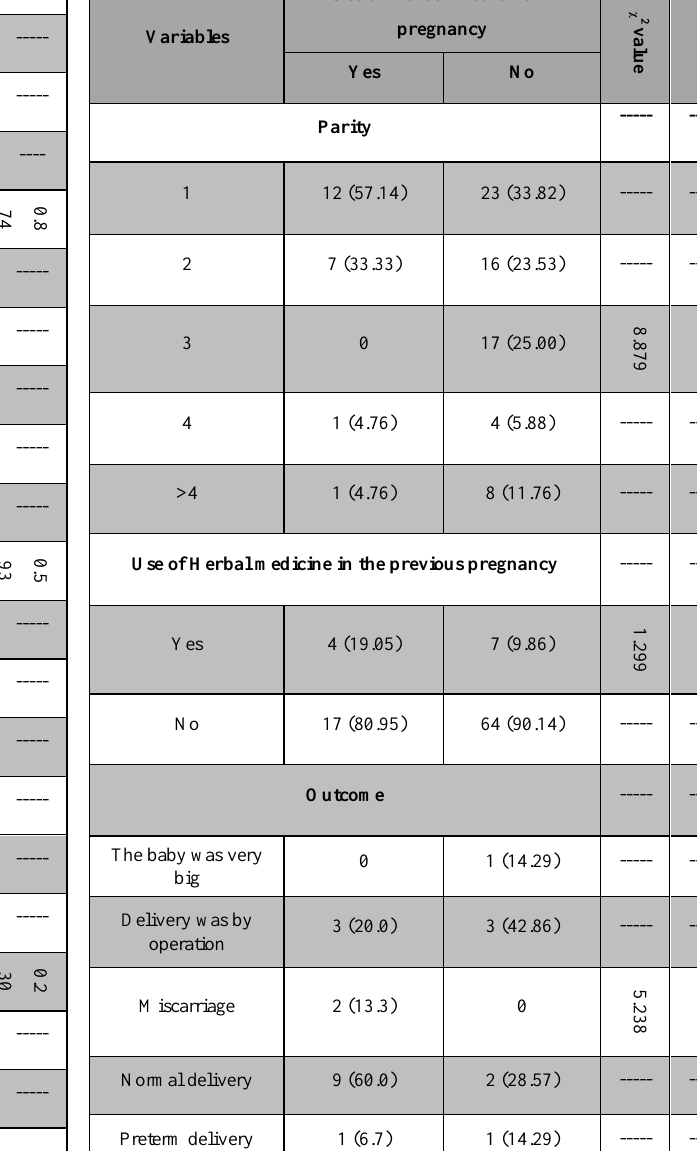
Table 6. shows factors associated with Herbal medicine use during pregnancy. The association between the use of Herbal medicine in pregnancy and parity was statistically significant with a p-value of 0.032. Table 6. Factors associated with Herbal medicine use during